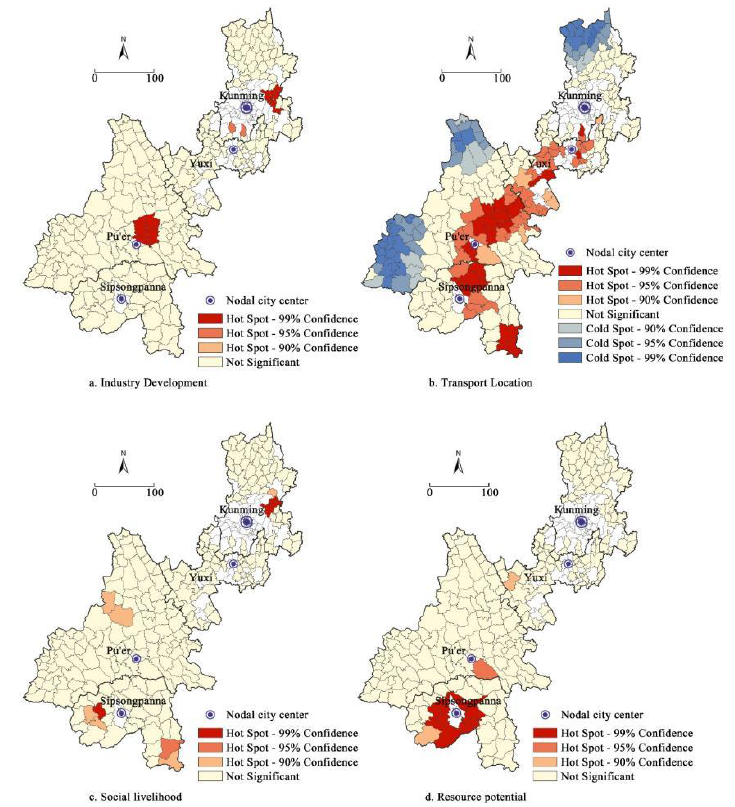
Figure 4. Clustering results of small towns in four dimensions.